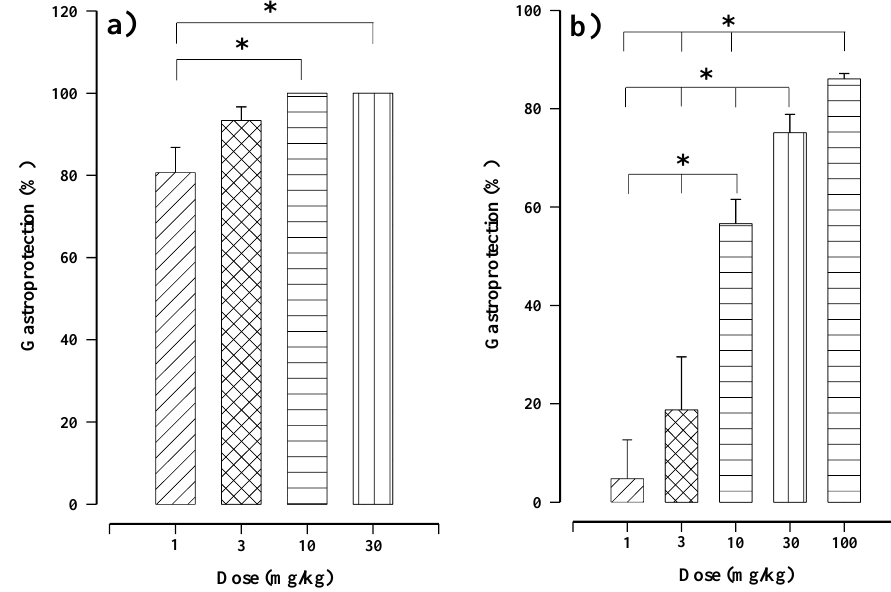
Figure 3. In the rat model of ethanol-induced gastric lesions, distinct levels of gastroprotection resulted from di ff erent treatments: ( a ) juanislamin (1–30 mg / kg) and ( b ) carbenoxolone (1–100 mg / kg). Bars represent the mean ± SEM ( n = 7). * p ≤ 0.05, Kruskal–Wallis test followed by Dunn’s multiple comparison.